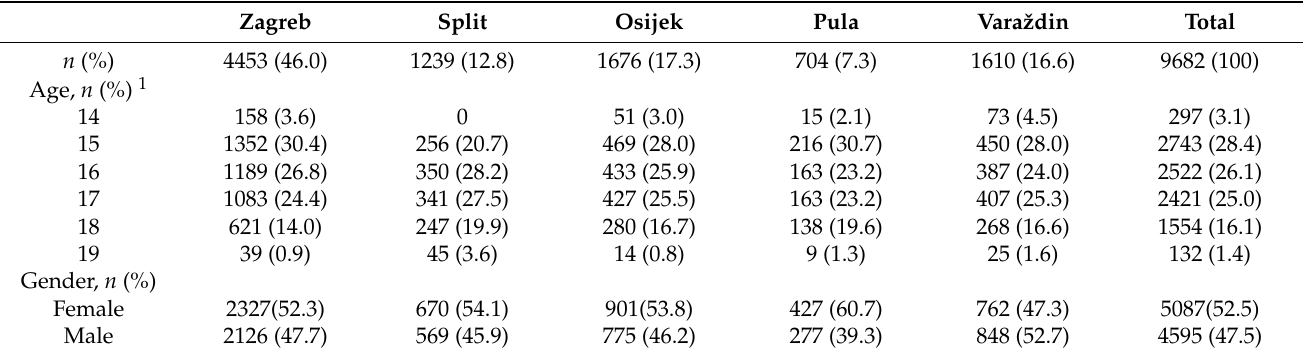
Table 1. Sociological demographic characteristics by data collection